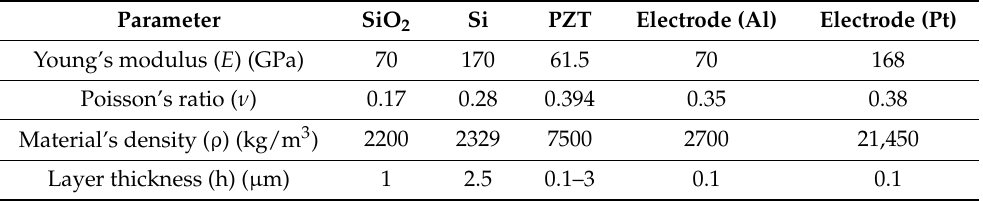
Table 1. The parameters of each layer in the